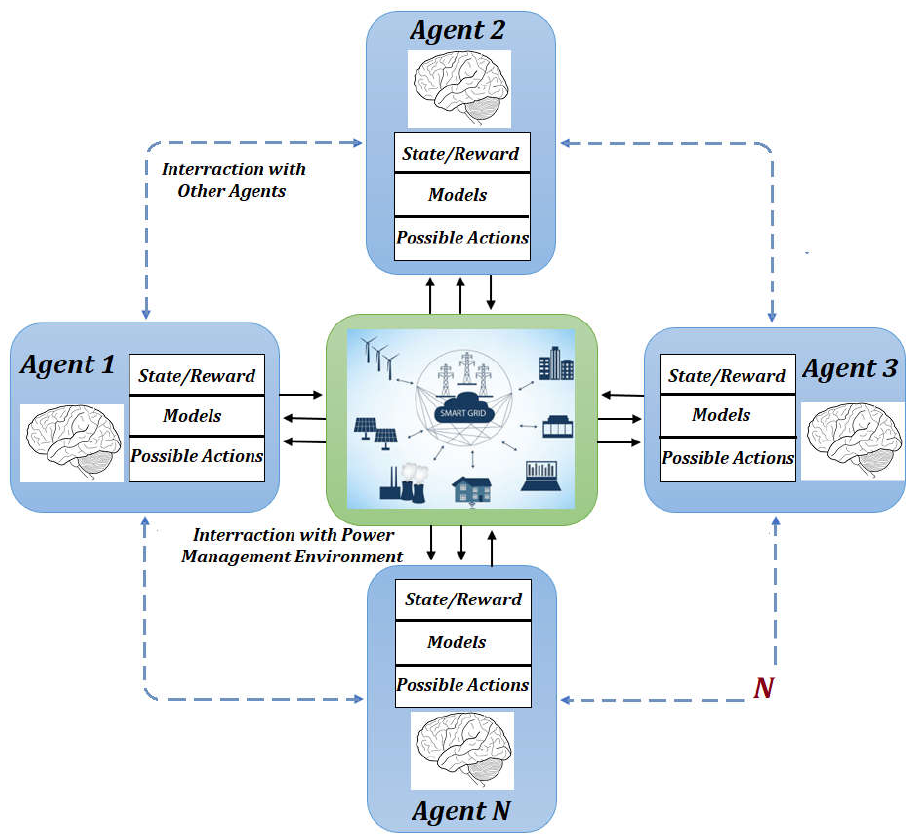
Figure 8. The multiagent interaction of the N number of active agents and the environment. MARL solutions are typed and classified based on the kind of the given reward.